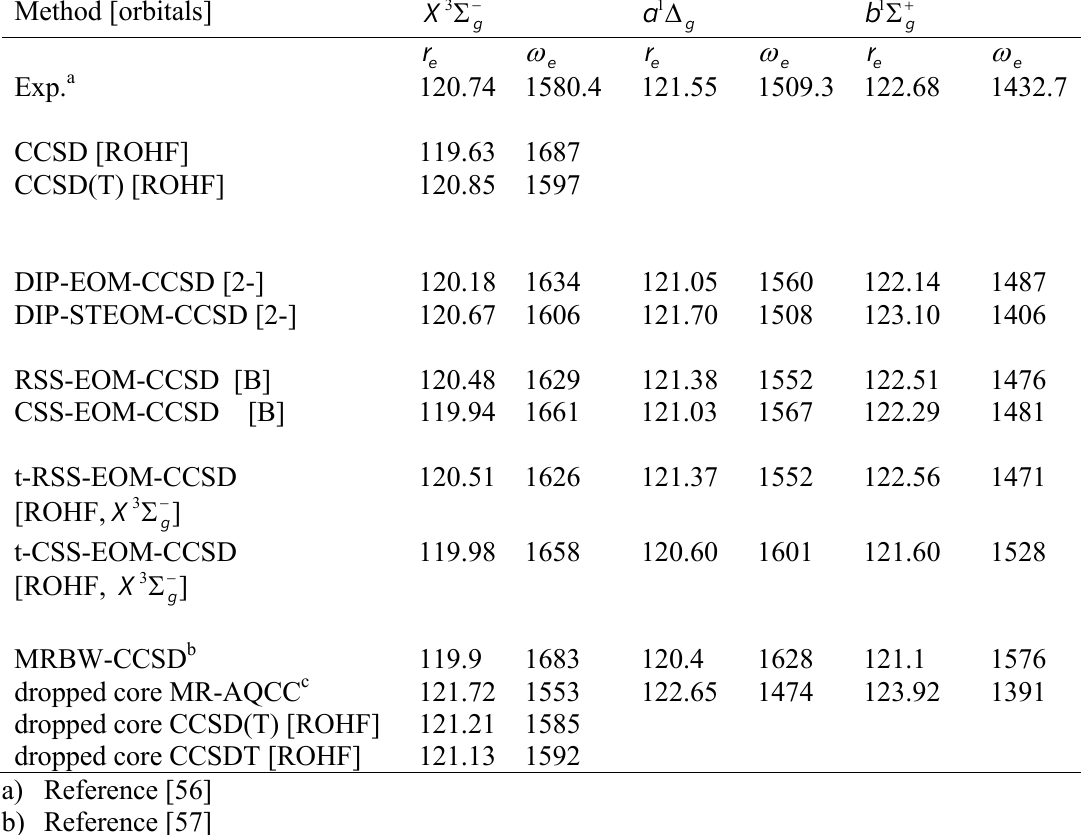
Table I. Internuclear distances (in pm) and harmonic vibrational frequenties in (cm -1 ) for the O ground state and low-lying singlet states. Calculations in cc-pVTZ basis